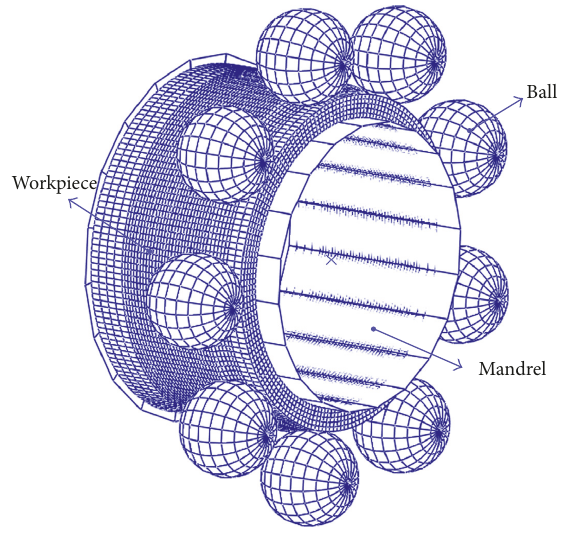
Figure 3: Finite-element